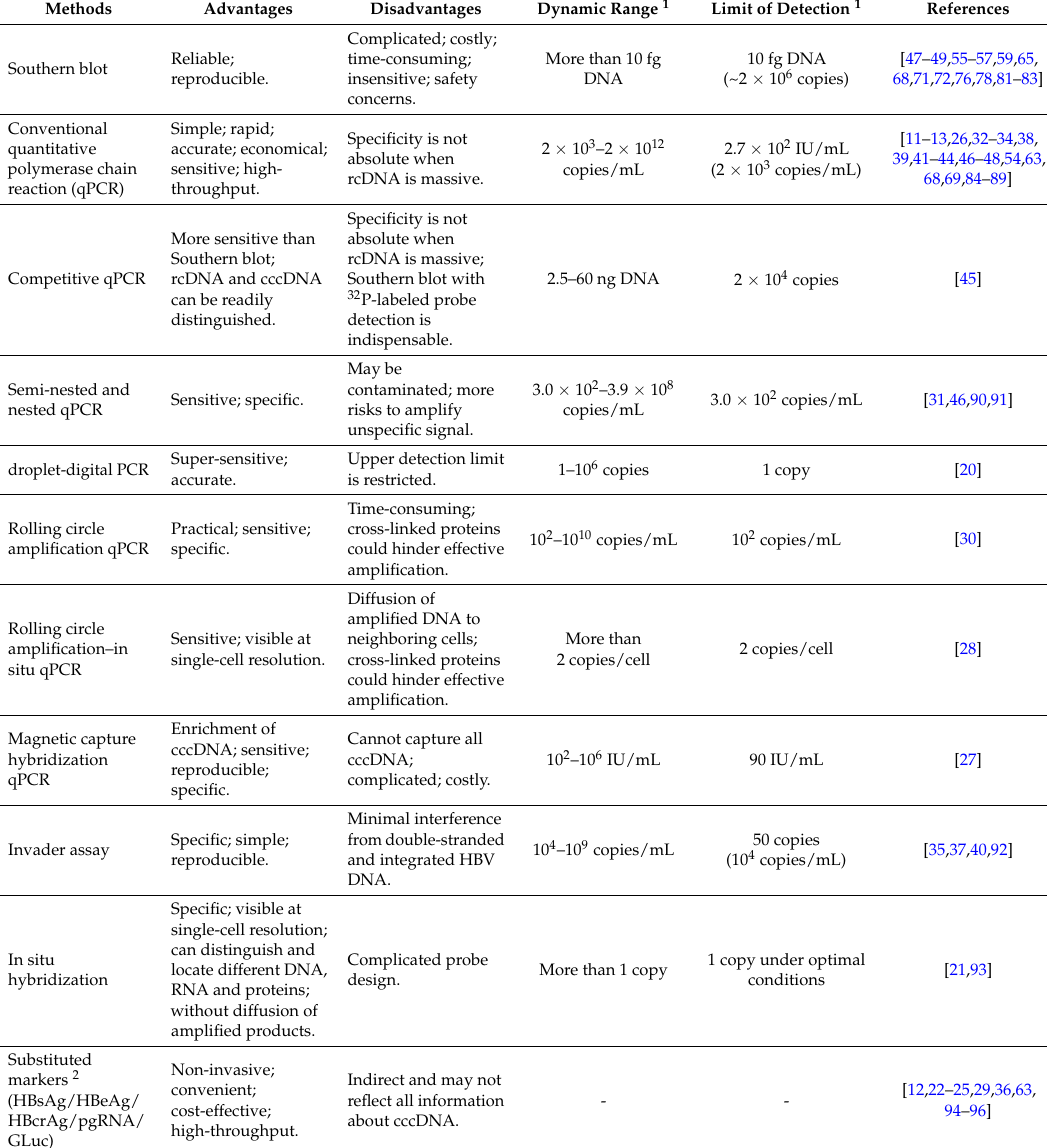
Table 1. Comparison of various methods for cccDNA